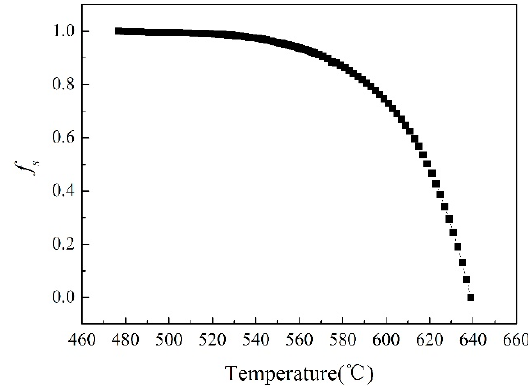
Figure 2. Solid fraction of the 7075 aluminum alloy versus temperature.